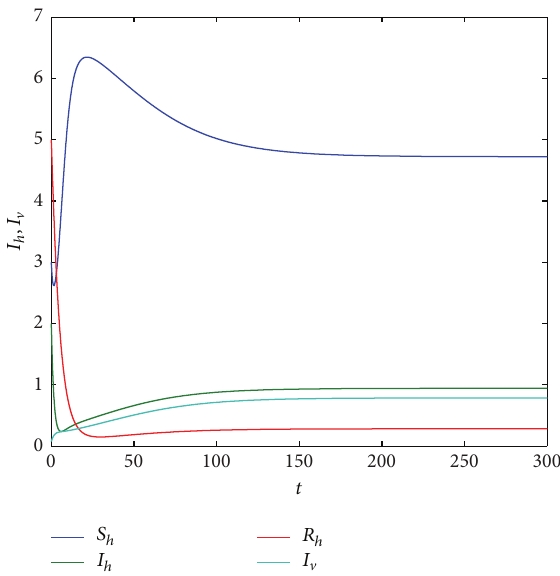
Figure 5: Trajectory picture with time 𝑡 when 𝑟 = 0.8 , 𝐾 = 10 , = 1 , 𝑎 = 1 , 𝑎 = 0.3 , 𝑑 𝛽 1 1 2 = 0.06 , 𝛽 = 0.26 , and 𝑁 𝑑 V 2